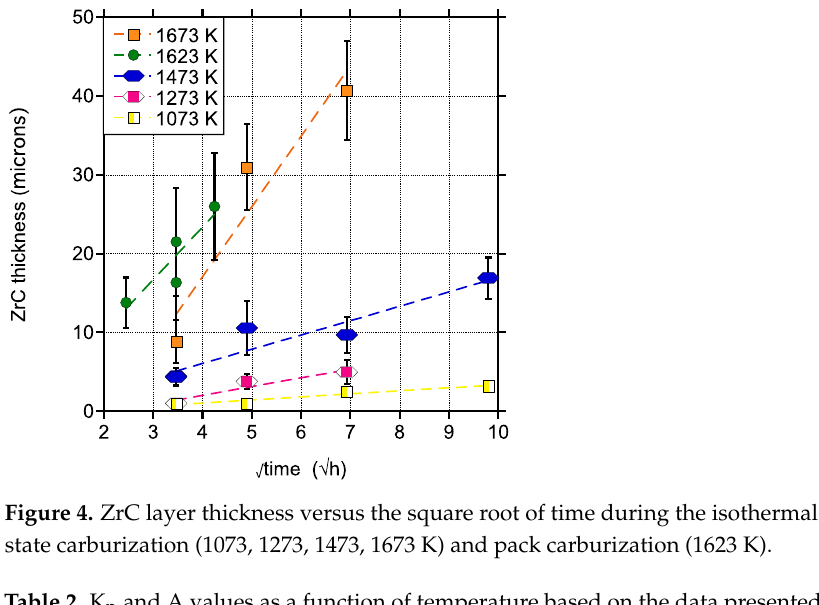
Figure 3. XRD patterns of as received Zry-4 (solid sample) and carburized Zry-4 (ZrC layer grown on solid Zry-4 samples) at 1073 K, 1273 K, and 1473 K for 12 h. Reference patterns for ZrC 0.63 (ICSD 14822 [22]), ZrC (ICSD 159874 [23]), and Zr (ICSD 53785 [24]) are also shown.